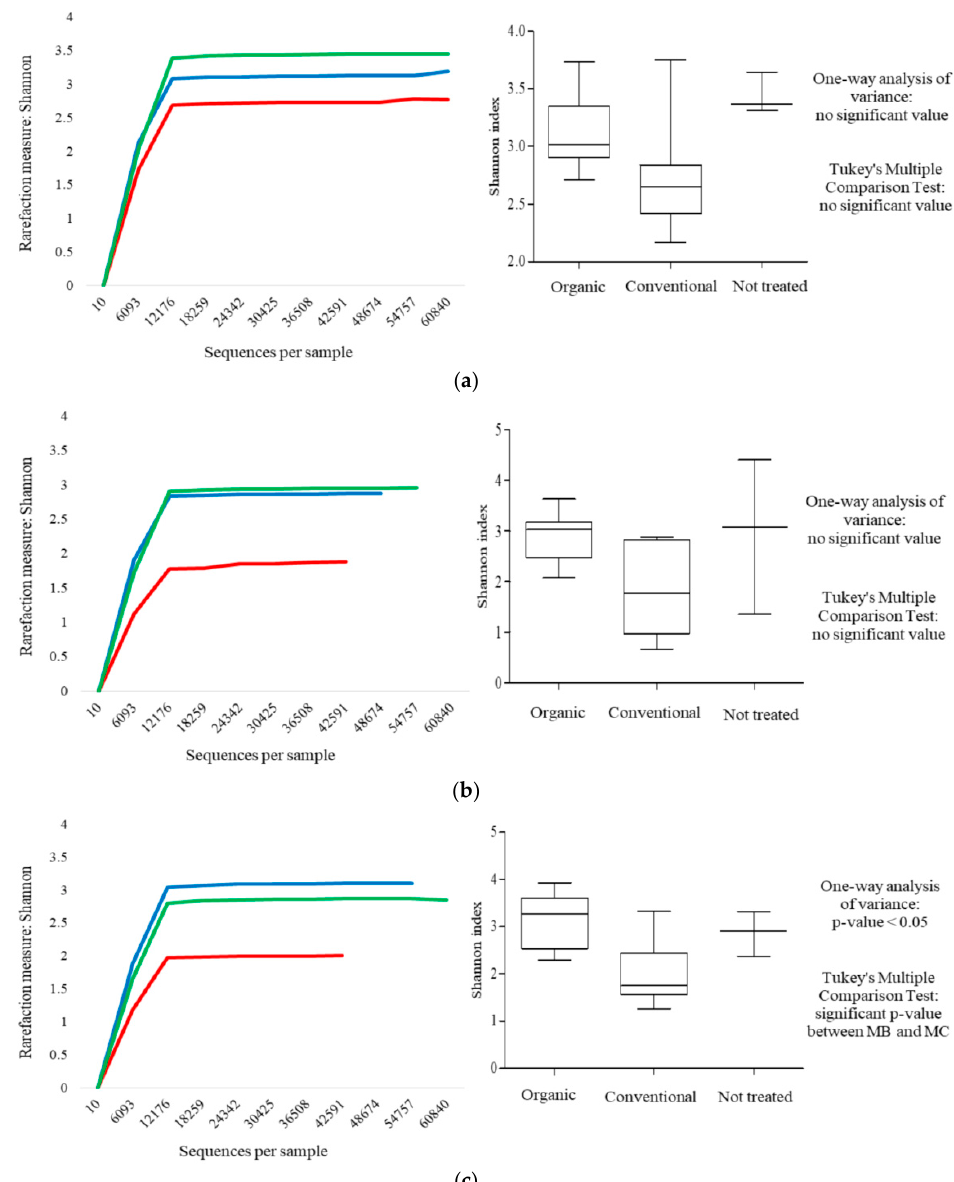
Figure 1. Rarefaction curves (on the left) and box-and-whisker plots (on the right) generated for mean values of fungal internal transcribed spacer (ITS) sequences obtained from MO ( ), MC ( ) and MNT ( ) grapes. The results were obtained using the Shannon index. ( a ), ( b ), ( c ) represent rarefaction curves and box-and-whisker plots referred to harvest time and at the 7 th and 15 th day of spontaneous fermentation, respectively.